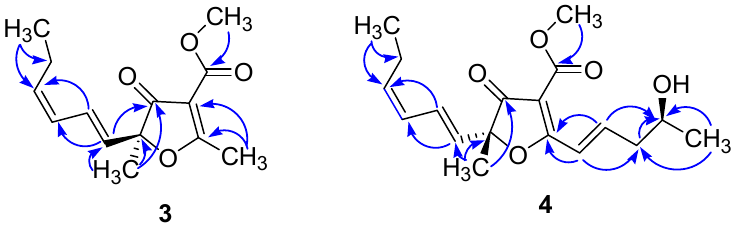
Figure 2. Selected HMBC correlations for Compounds 3 and 4 .